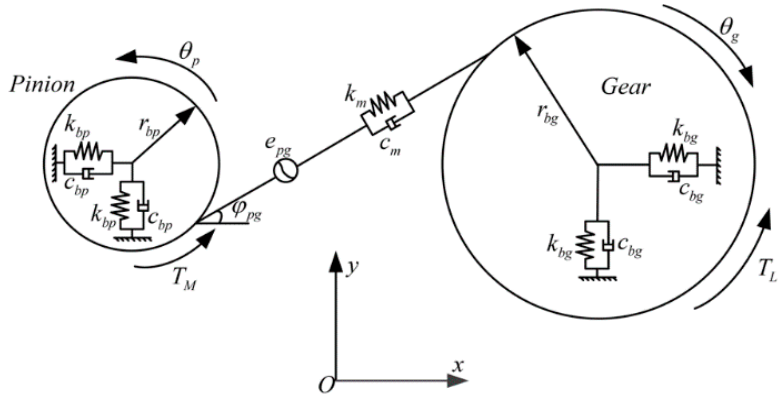
Figure 4. Dynamic model of the six-degree of freedom gear system.